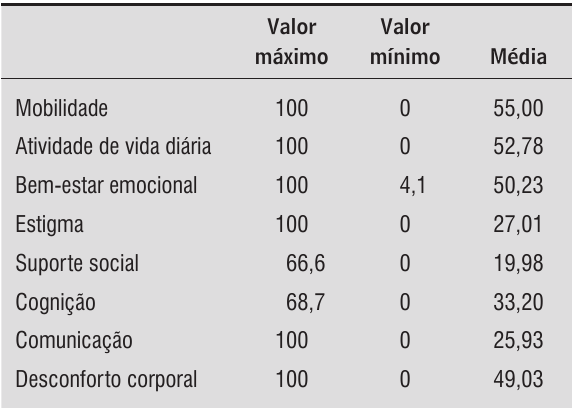
Tabela 1 - Valores máximos, mínimos e a média